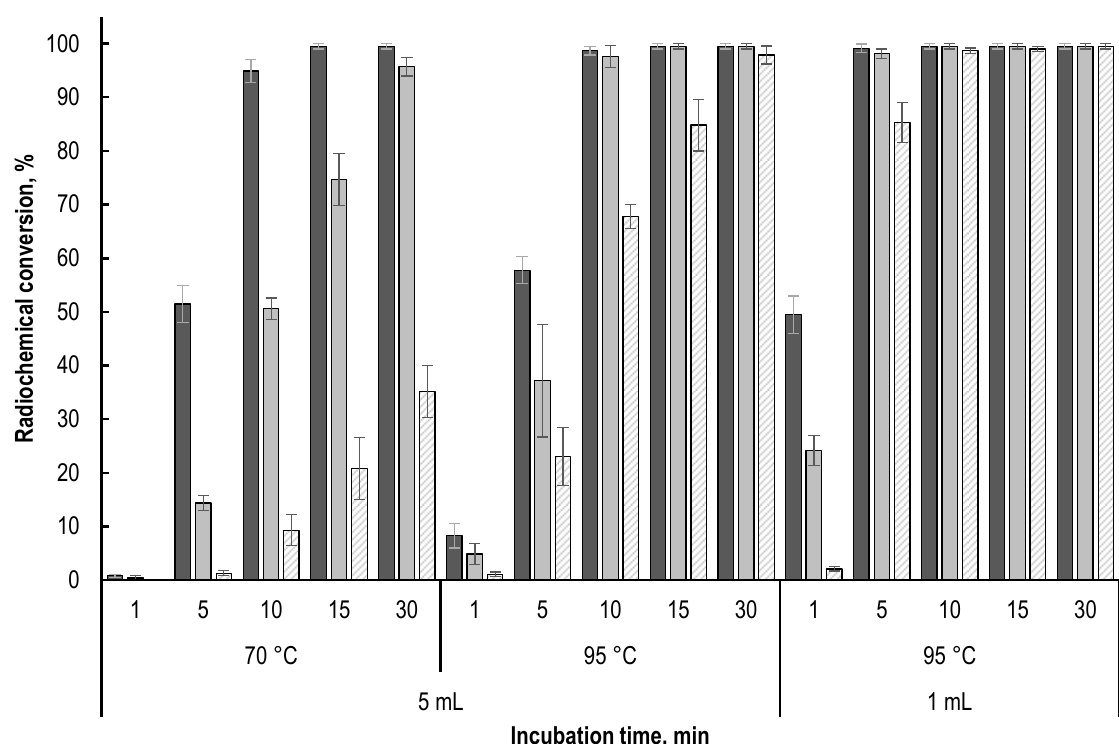
Figure 10. Influence of sodium acetate concentration at different temperatures and volumes of the reaction mixture on the kinetics of [ 177 Lu]Lu-PSMA-617 formation ( 177 Lu activity in each sample— 150 MBq, 20 µ g of PSMA-617, pH 4.5; labelling yield (radiochemical conversion) value is presented as mean ± SD, n = 3).